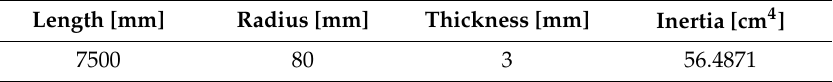
Table 3. Second test: geometrical